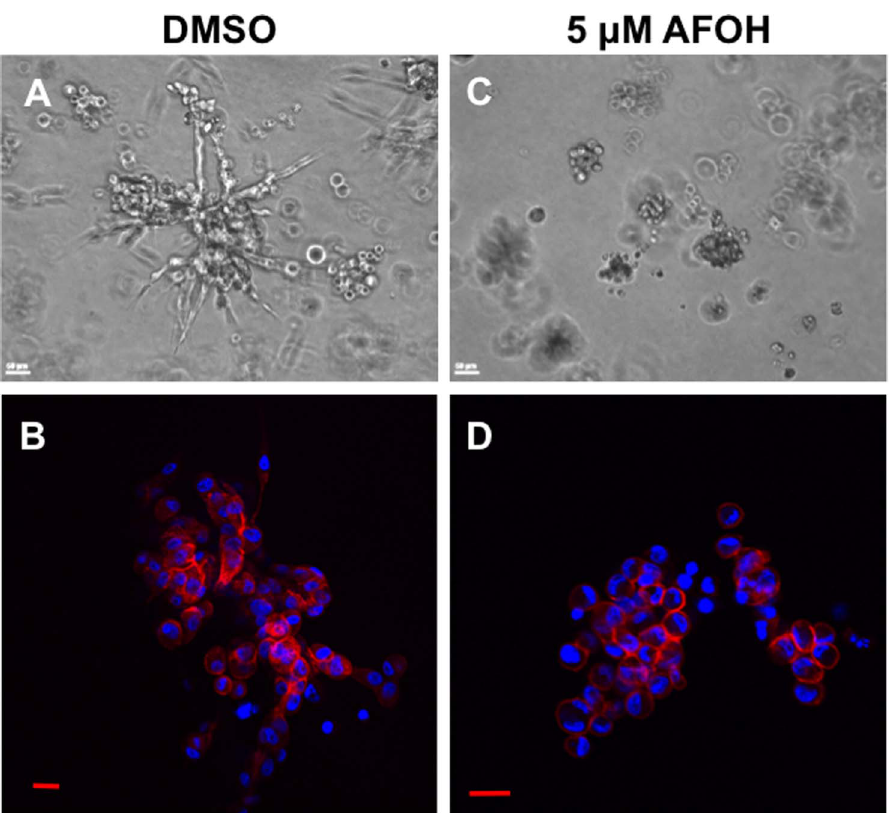
Figure 8. AFOH blocks 3D invasive growth of MDA-MB-231 cells. Cells were seeded in growth factor reduced Matrigel, treated with DMSO (A, B) or 5 m M AFOH (C, D) for 10 days. Then phase contrast images were taken from randomly chosen fields (A, C). Colonies grown in Matrigel were smeared onto slides, immunostained for F-actin (red) and nuclei (blue), and then imaged by confocal microscopy (B, D). The representative images from three experiments are shown.